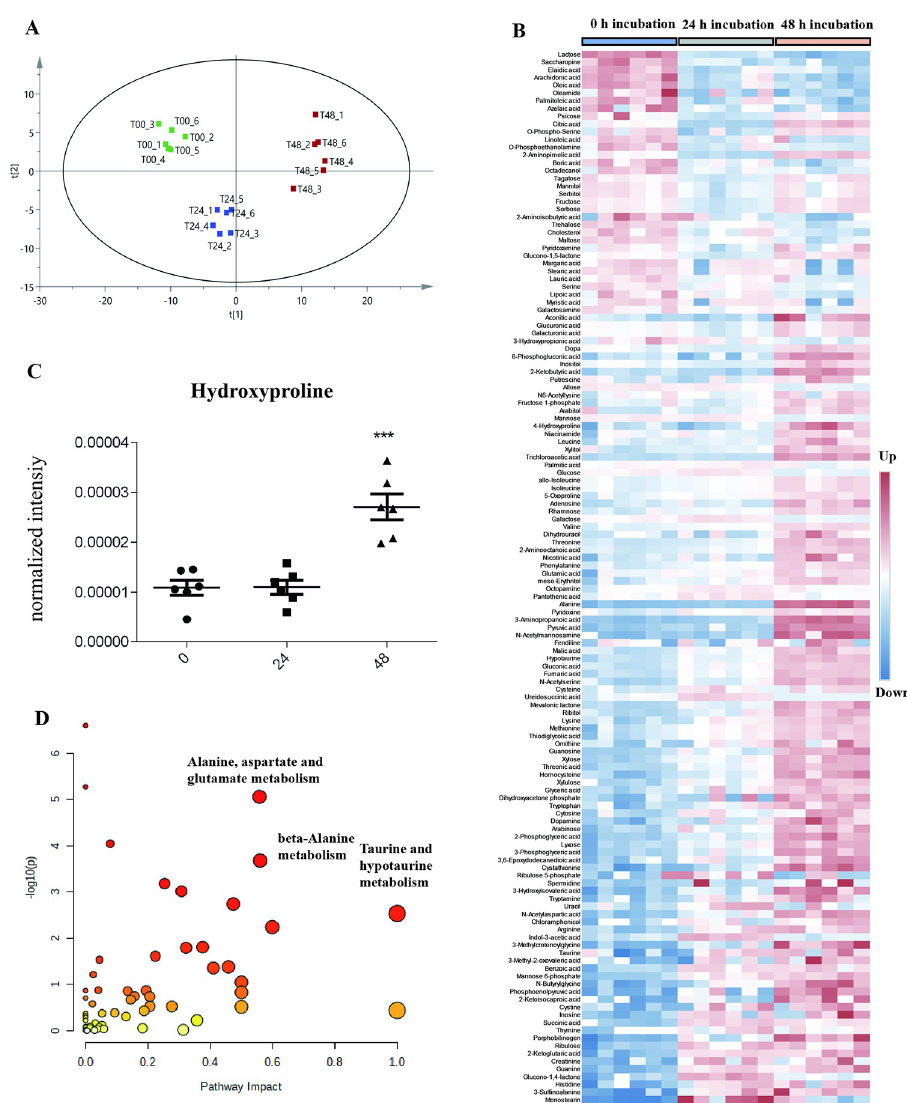
Fig 6. Metabolic profiling of BEAS-2B treated with silica. (A) PCA analysis of samples treated with silica for 0, 24, or 48 h. (B) Heatmap of differentially abundant metabolites in response to treatment with silica for 0, 24, or 48 h. (C) Changes in levels of hydroxyproline as determined using GC-MS analysis. Data are presented as the mean ± SEM; *** , p < 0.001. (D) Metabolic pathway analysis of differentially abundant